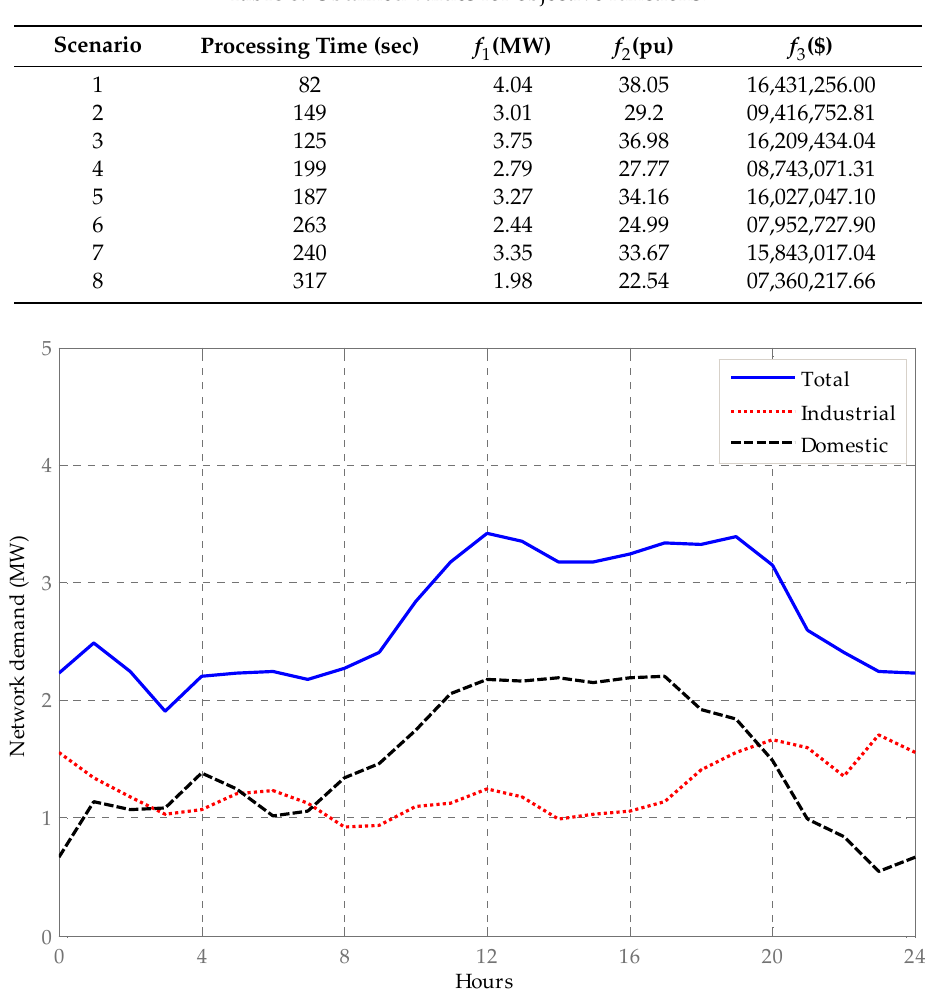
Table 8. Obtained values for objective functions.